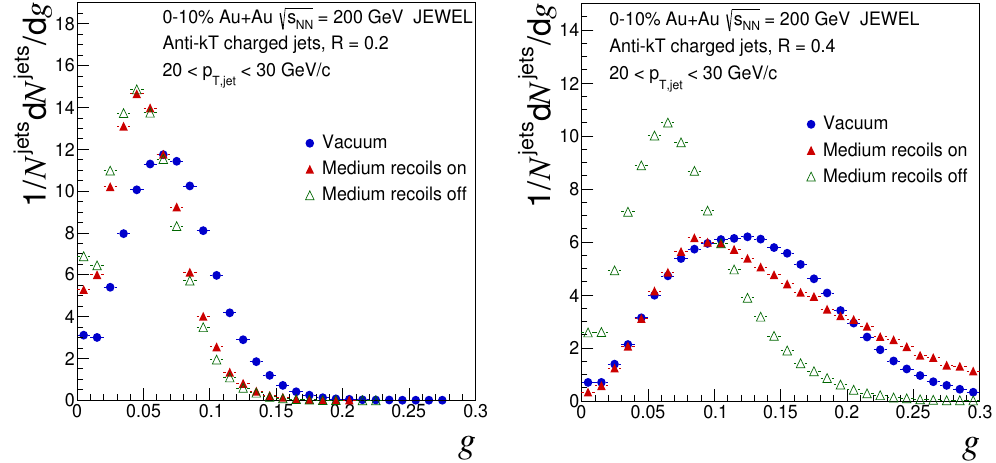
Figure 4. Girth for jets with p T of 20–30 GeV/ c and R = 0.2 ( left ) and R = 0.4 ( right ) in central Au+Au √ s NN = 200 GeV. collisions at